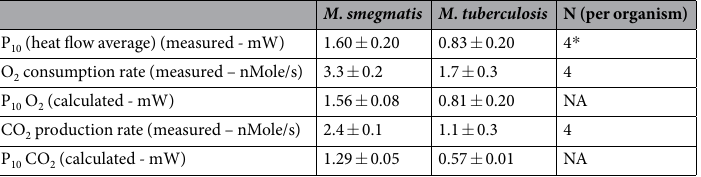
Table 1. Average heat production rate (P 10 , from IMC) and gas production or consumption rate (from TDLAS) during the first 10 hours. To compare IMC and TDLAS, theoretical heat flow values were recalculated from oxygen consumption rate and carbon dioxide production rate using Equation 1. * 7 replicates were measured for M. tuberculosis